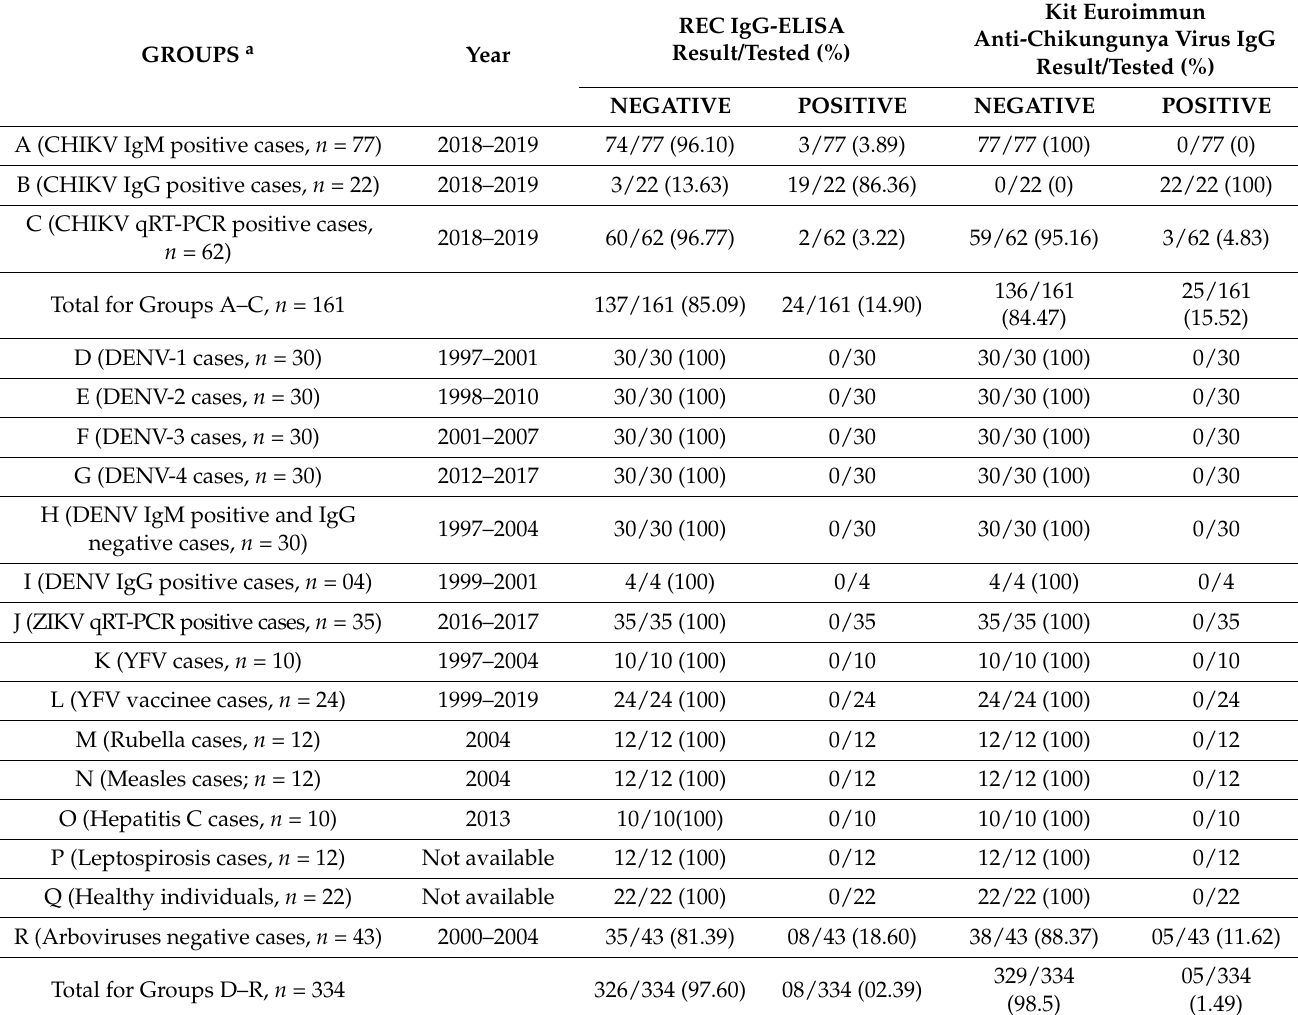
Table 1. Evaluation of the MULTREC IgG-ELISA for chikungunya diagnosis based on the analysis of the distinct